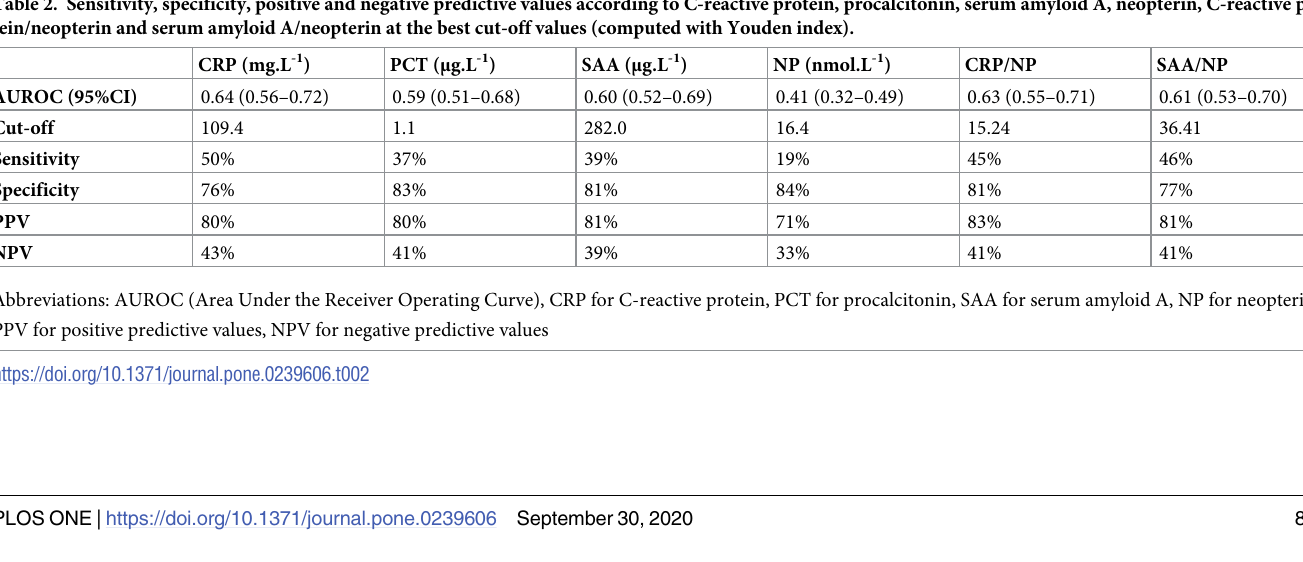
Table 2. Sensitivity, specificity, positive and negative predictive values according to C-reactive protein, procalcitonin, serum amyloid A, neopterin, C-reactive pro- tein/neopterin and serum amyloid A/neopterin at the best cut-off values (computed with Youden index). CRP (mg.L -1 ) PCT ( μ g.L -1 ) SAA ( μ g.L -1 ) NP (nmol.L -1 ) CRP/NP AUROC (95%CI) 0.64 (0.56–0.72)